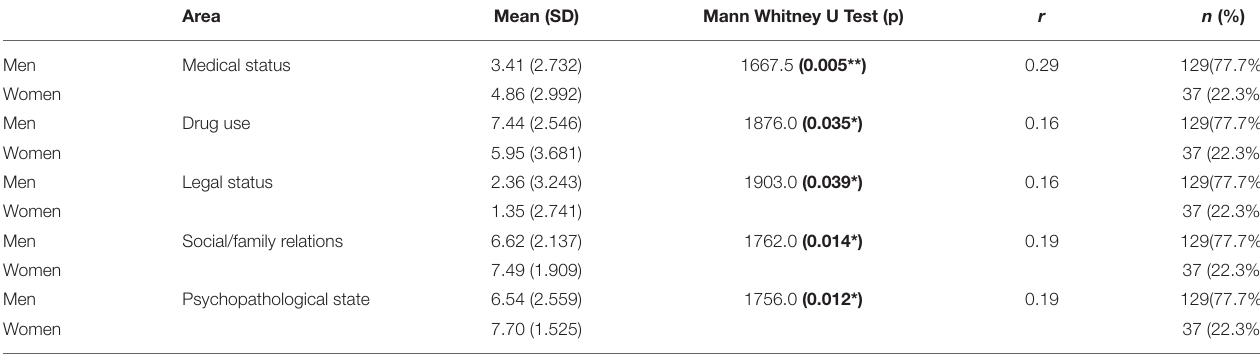
TABLE 6 | Differences by sex.